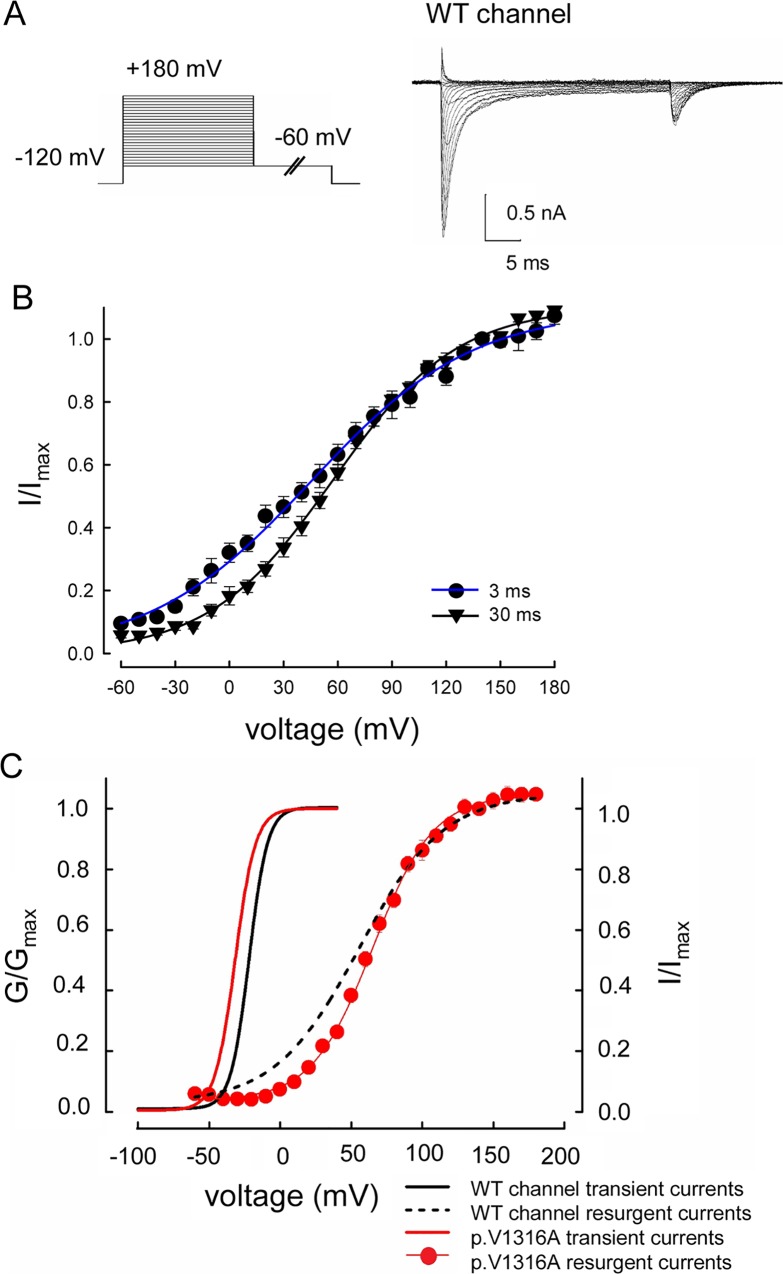
The activation curve of resurgent Na+ currents in the WT and p.V1316A mutant channels.(A) Sample sweeps were obtained in the presence of 0.1 mM Navβ4 peptide for the WT channel. The cell was first held at –120 mV for ~30 ms, and then stepped to different depolarization prepulses between –60 and +180 mV for 30 ms in 10 mV increment. Resurgent Na+ currents were then evoked by a pulse to –60 mV for 150 ms. (B) The relative magnitude of resurgent Na+ currents for the WT channel is defined by normalization of the peak amplitude of resurgent Na+ currents at –60 mV following different prepulses to that following a prepulse of +140 mV in the same cell, and then plotted against the prepulse potential. The same experiments were also repeated with prepulses only 3 ms in length. The resurgent activation curve for each cell are also obtained by fittings with Boltzmann functions, and the cumulative results for Vh are 38.63±4.39 mV and 49.19±2.58 mV for 3 ms and 30 ms prepulses, respectively (n = 10 for the 3 ms; n = 9 for the 30 ms), and k are 39.40±3.37 and 29.01±1.46 for 3 ms and 30 ms prepulses, respectively. Single Boltzmann fits to the mean values are for 3 ms: Vh = ~44.93 mV, k = ~43.63, and for 30 ms: Vh = ~48.63 mV, k = ~28.59. (C) The activation curve of resurgent Na+ currents in the p.V1316A mutant channel is obtained with the same protocols as that in part B (prepulse = 30 ms, n = 10). The activation curves of transient Na+ currents for the WT and p.V1316A mutant channels and the activation curves of resurgent Na+ currents in the WT channels (the fitting lines in Figs 3B and 4B, and part B, respectively) are replotted for comparison. The resurgent activation curve of p.V1316A mutant channels for each cells are also obtained by fitting Boltzmann functions, and the cumulative results for Vh and k are 59.76±2.17 mV (n = 10; p < 0.05 versus the activation curve of transient currents in the p.V1316A mutant channels) and 21.70±1.14 (n = 10; p < 0.05 versus the activation curve of transient currents in the p.V1316A mutant channels), respectively. Single Boltzmann fits to the mean values are for p.V1316A mutant channel: Vh = ~59.5 mV and k = ~21.39. Note that the activation curves of resurgent Na+ currents in both WT and p.V1316A mutant channels are markedly shifted to the more positive voltage range and with a much less steep slope than those for the transient currents. Individual data is shown in the file of S1 Data.